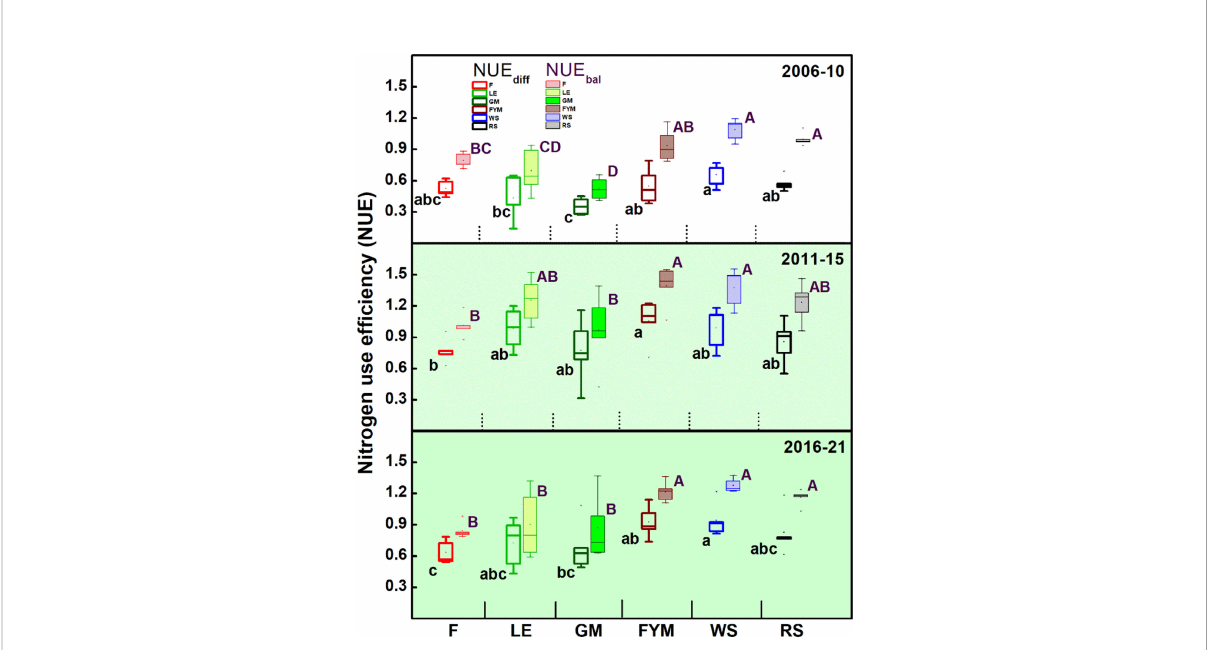
FIGURE 2 Trends in the nitrogen use ef fi ciency (NUE) for rice crop during 15 years (2006-2021) of different nutrient management. Management: Error bars denote ± 1SD. Different letters (capital for NUE bal and lower for NUE diff ) indicate signi fi cant differences for NUE (P ≤ 0.05). O= no fertilizer, F= 100% inorganic fertilizer, LE= Legume ( Vigna radiata ) in rotation and its biomass incorporation + ~50% inorganic fertilizers, GM= Green manuring with Sesbania esculeata + ~50% inorganic fertilizers, FYM= farmyard manure incorporation + ~50% inorganic fertilizers, WS= 1/3